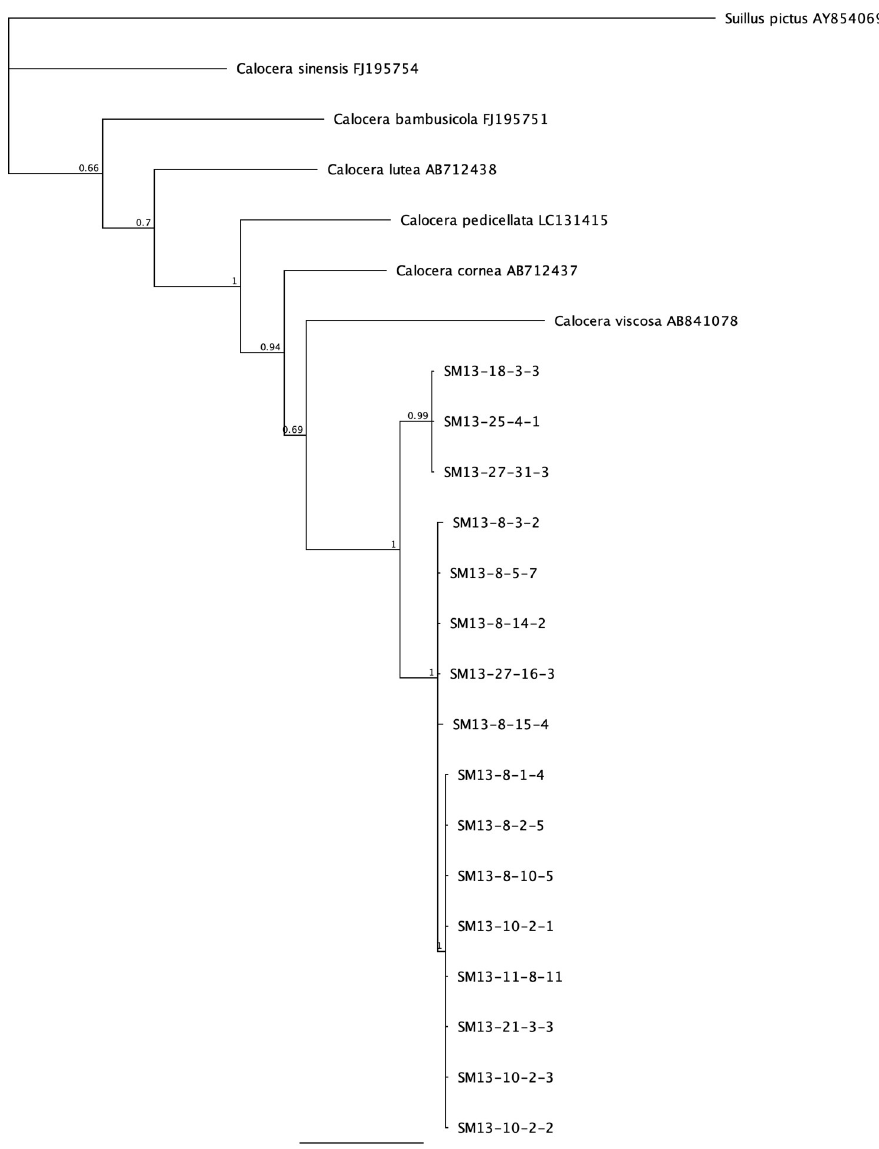
Fig 4. Bayesian tree constructed using ITS sequences from Calocera species isolated from the Soudan mine (preceded with “SM”) and related genera. Posterior probabilities are shown at branches.